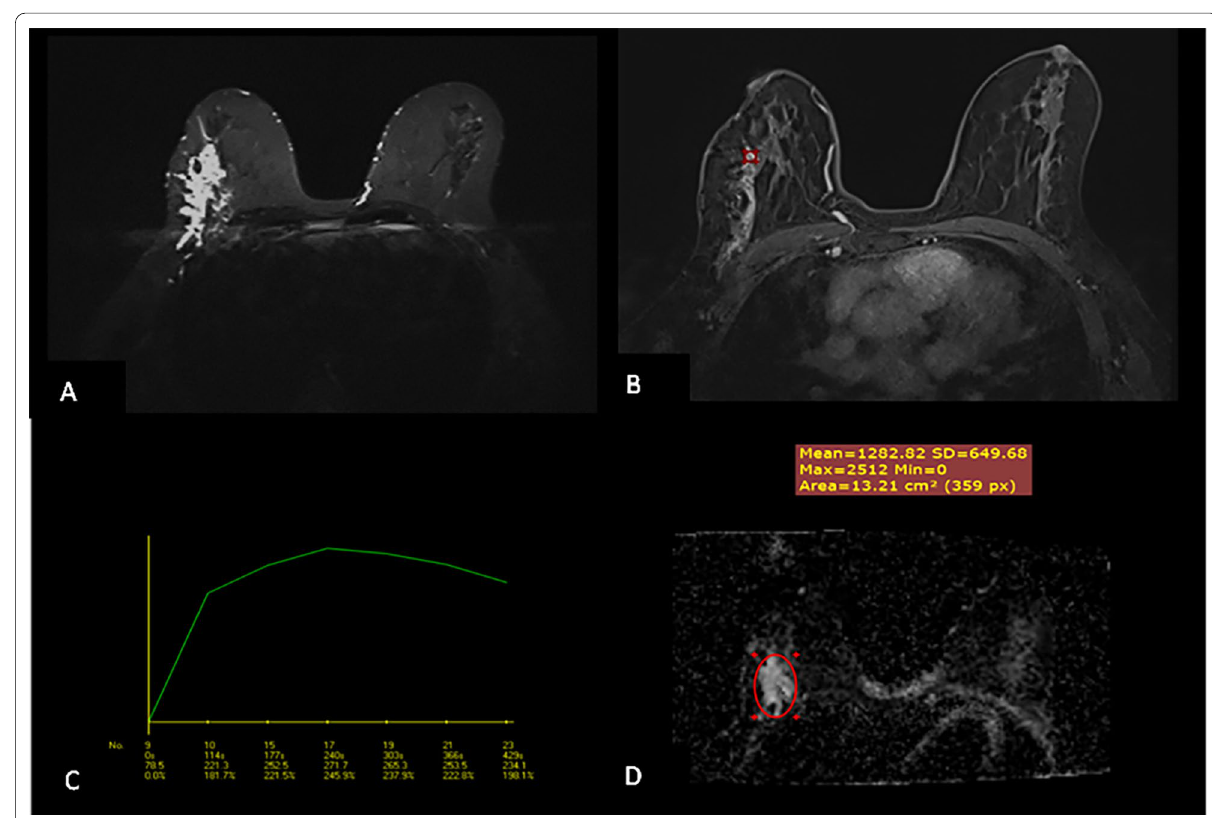
Fig. 4 Case 3: 35 years old with a long history of OCP use. Sonomammographic assessment revealed right breast UOQ asymmetry with underlying parenchymal distortion on U/S (not illustrated on images). DCE‑MRI: STIR ( A ), post‑contrast dynamic sequences ( B ) with time–intensity curves ( C ), and ADC mapping ( D ) revealed right breast UOQ non‑mass enhancement showing type III (washout) curve on plotting time–intensity curve ( C ) and ADC value of 1.28 ( D ). Histopathological results of U/S guided trucut biopsy revealed ADH and apocrine metaplasia. Surgical excision after wire localization histopathological results revealed ADH with